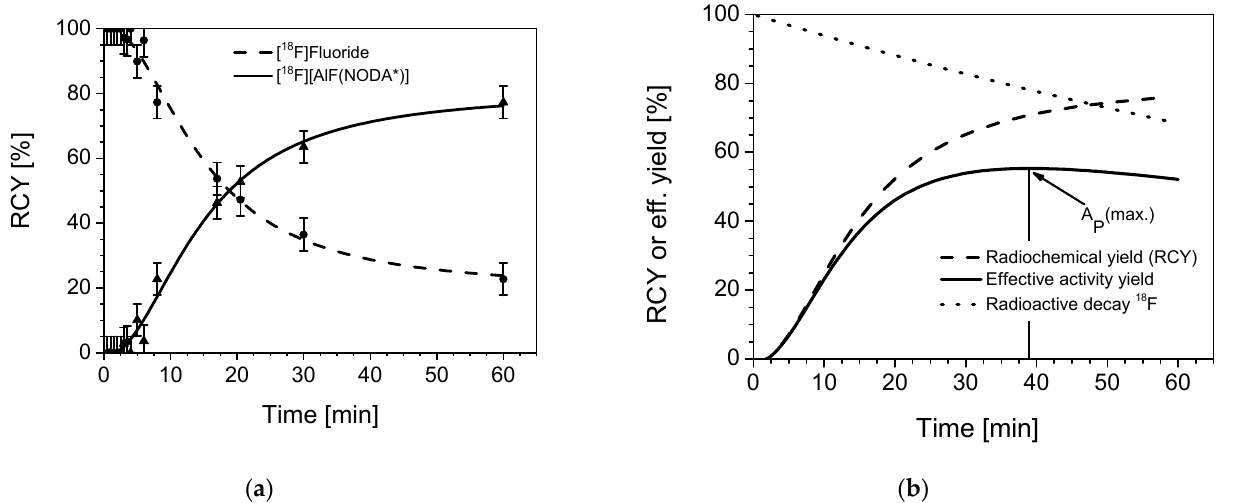
Figure 6. ( a ) Time dependency (kinetics) of [ 18 F]fluoride exchange coordination with the [Al(OH)(NODA*)] complex according to a pseudo first order reaction, resulting in [ 18 F][AlF(NODA*)] ( b ) Course of the radiochemical yield (RCY, dashed), 18 F decay curve (dotted) and combined calculated effective activity yield (straight) over time. Reaction parameters: 0.33 mM [Al(OH)(NODA*)], 0.25 M of NH 4 OAc-buffer, pH 4.5, 105 °C, total volume of 300 µL, solvent: water/ethanol 83:17.